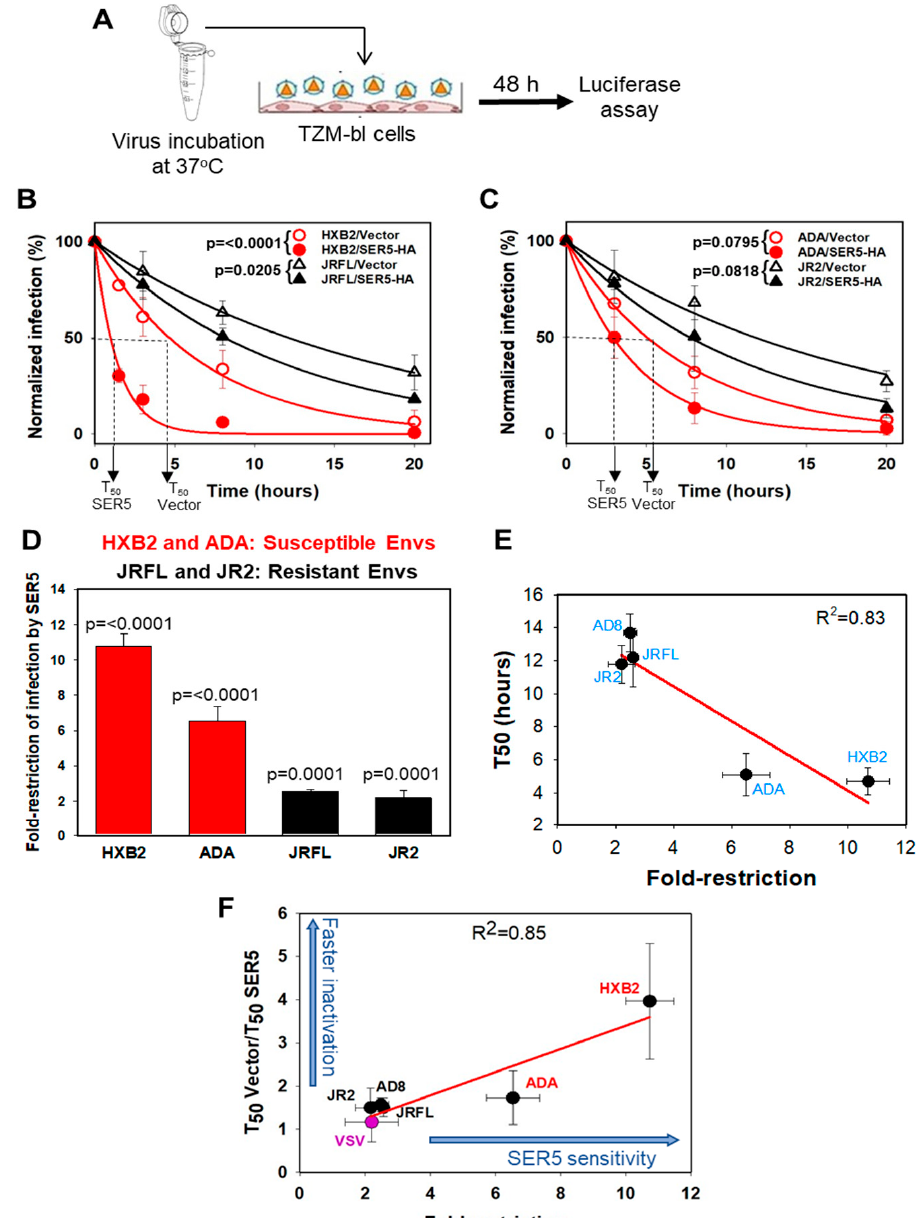
Figure 1. Spontaneous inactivation of HIV-1 Env glycoproteins induced by SER5 correlates with the degree of restriction. ( A ) Schematic diagram of experimental setup. Pseudoviruses were incubated at 37 ◦ C, 5% CO 2 in HEPES-buffered medium for various durations. Pseudovirus infectivity was monitored by firefly luciferase activity in TZM-bl cells at 48 h post-infection. ( B , C ) Rates of infectivity decay for sensitive (red curves) vs. more resistant HIV-1 Envs (black curves). HIV-1 pseudoviruses containing or lacking SER5-HA were incubated at 37 ◦ C, 5% CO 2 , as indicated in ( A ). The luciferase signal for each pseudovirus was normalized to its respective freshly initiated preparation. Data points are means and S.D. from four (HXB2), and three (JRFL, ADA, and JR2) independent experiments, each performed in triplicate. The infectivity decay half-life (T 50 ) values calculated by single exponential decay (one-phase decay) fitting are listed in Table S1. The statistical significance of SER5-HA’s effect on HIV-1 rates of decay (ANOVA repeated measures test) is shown in the plots. ( D ) Fold restriction by SER5-HA of two sensitive (red), and two resistant (black) HIV-1 Envs analyzed in ( B , C ). Data are means and S.D. from the independent experiments mentioned in ( B , C ). The statistical